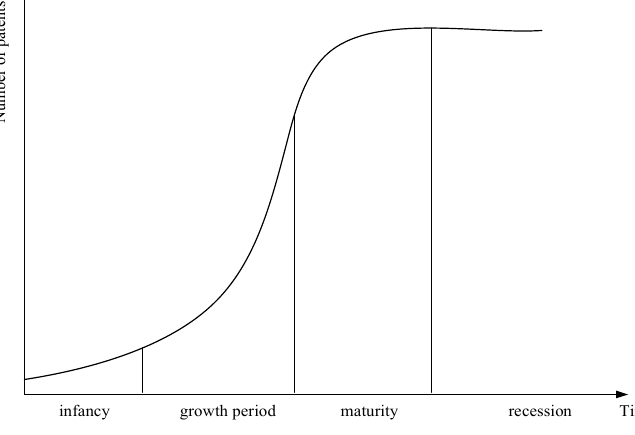
Figure 1. The development stages of the S-curve life cycle.